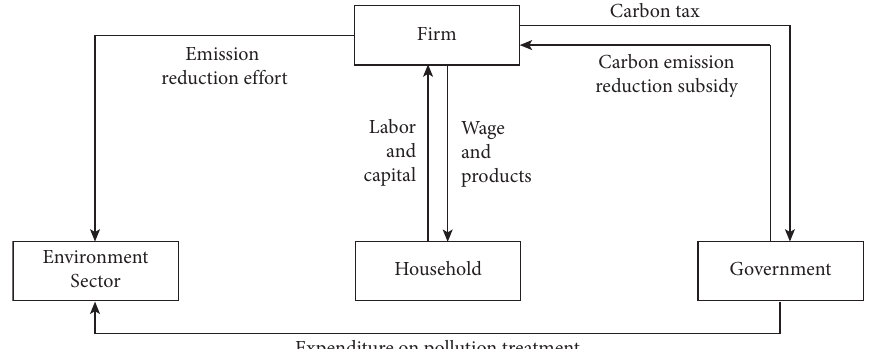
Figure 1: Logic structure diagram of the DSGE